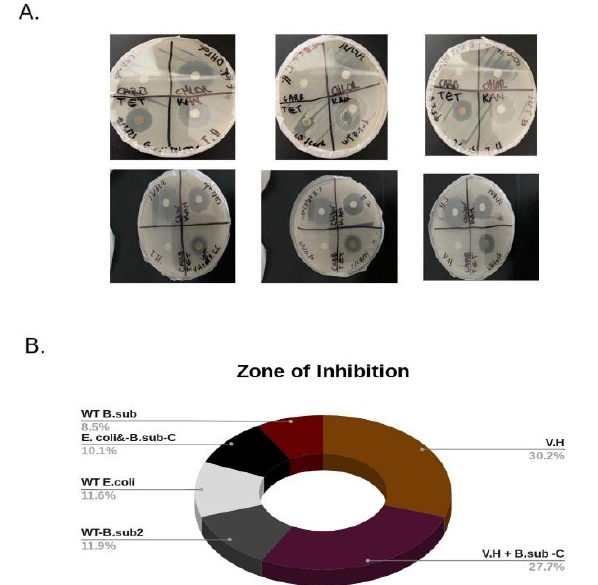
Figure 4 : Antibiotic Resistance Tests A. The top plates include the antibiotic resistant test results for E. Coli co-cultures and the bottom plates represent the results for V. harveyi sample groups. The top plates showed more moderate sensitivity to resistance of the antibiotics carbenicillin, chloramphenicol, tetracycline, and kanamycin. The WT E. Coli was more sensitive to tetracycline, chloramphenicol, and to kanamycin than the WT B. subtilis and the B.subtilis-Carrier-E. Coli co-culture. V. harveyi on the bottom plates showed identical and similar antibiotic resistance and sensitivity as the B.subtilis-Carrier-V.H and WT B. subtilis co- cultures. B. The zones of inhibition were measured in millimeters. The zone of inhibition for V. harveyi totaled 99 and 91 for B. subtilis-Carrier-V.H producing a 3.0% decrease in the zones of inhibition between each of these samples. The WT E. Coli had a total zone of inhibition of 8.5% that was raised to 10.1% for the B. subtilis-Carrier-E. Coli that yielded a total Zol of 33. The wild- type V. harveyi and E. Coli samples showed increased antibiotic sensitivity, however, the B. subtilis-Carrier-V.H and B. subtilis- Carrier-E. Coli co-cultures increased in antibiotic